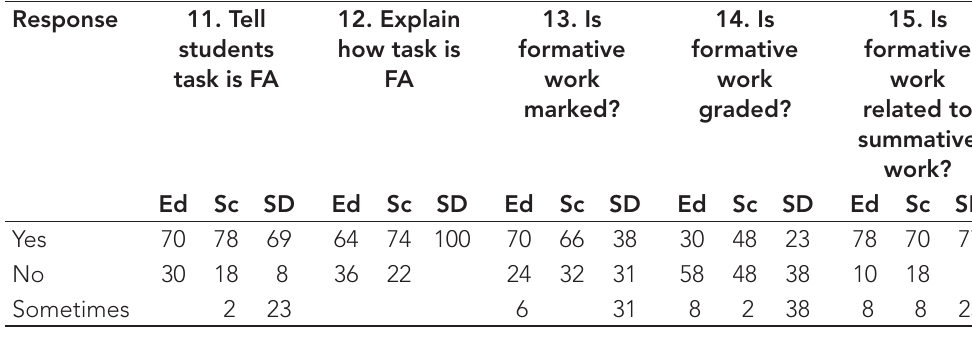
Table 7: Information given to students on formative assessment tasks